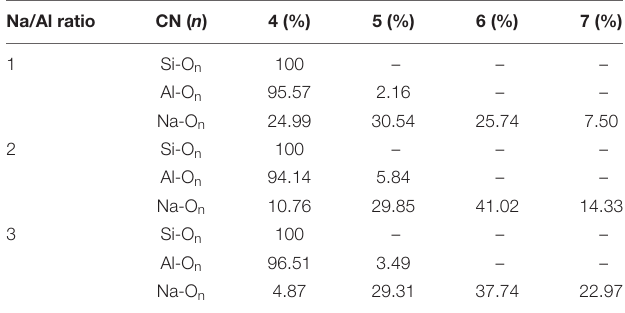
TABLE 2 | Coordination number (CN) of NASH gel model with different Na/Al ratios. Na/Al ratio